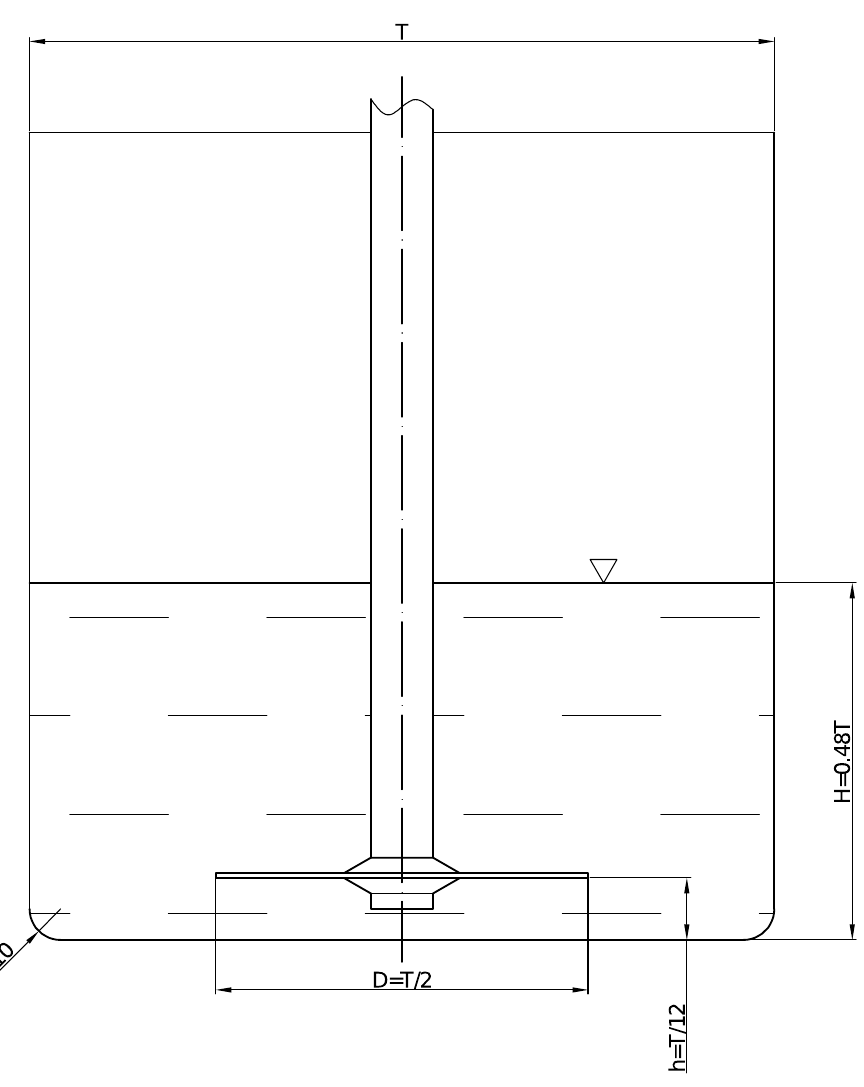
Figure 1. Tank geometry. T is the internal tank diameter, D is the impeller diameter, H is the liquid level, h is the impeller level above the bottom, and R is the radius of bottom rounding.